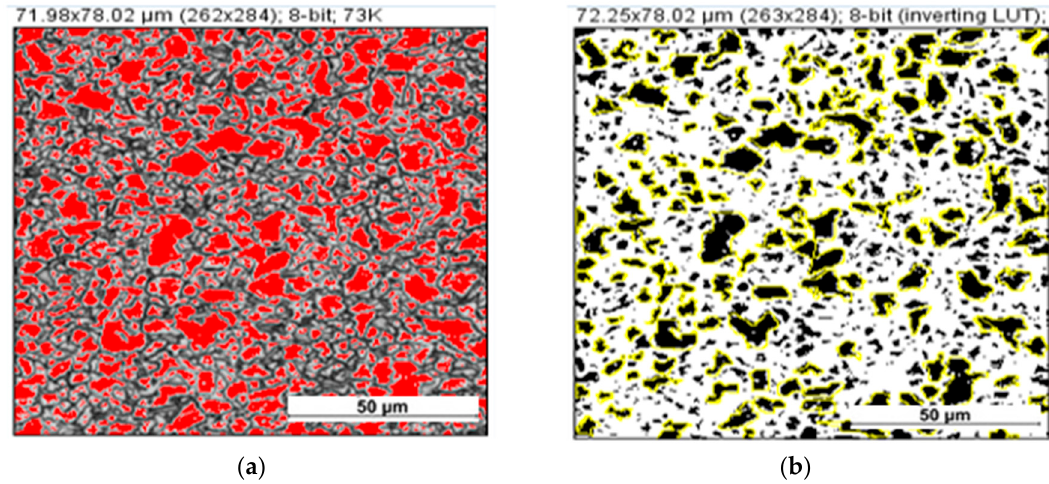
Figure 11. The microstructure of the FGHAZ region of TMCP steel for the second welding condition: ( a ) calibration using Threshold ImageJ; ( b ) measurement of grain area using ImageJ 1.52p 22. The average austenite grain size was 89.0 µm 2 (ASTM E112-13 grain size 4). Within the prior